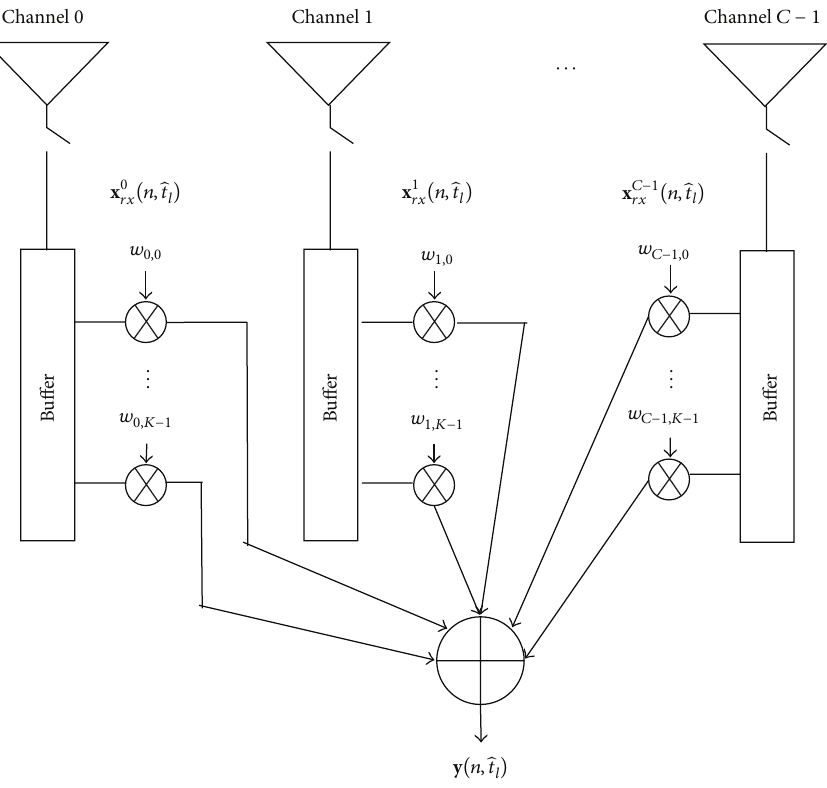
Figure 1: Space-fast-time